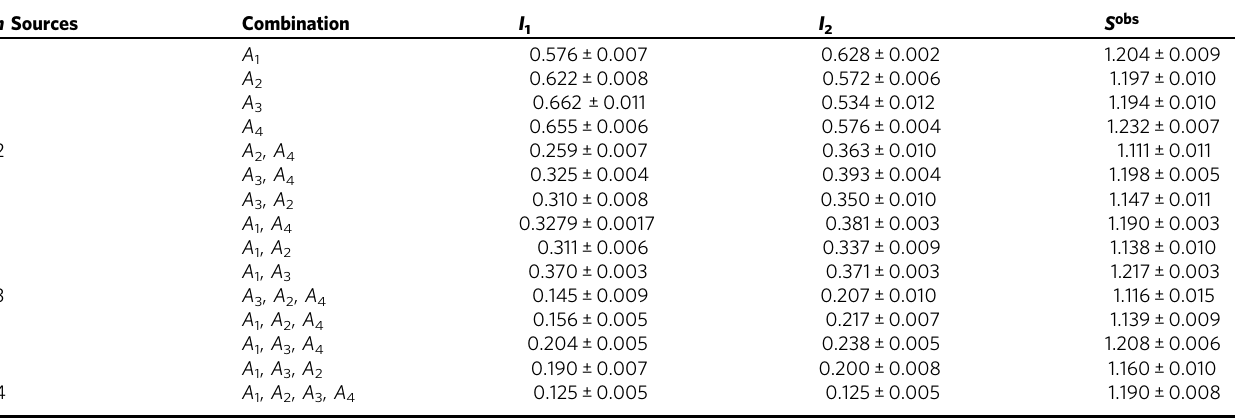
Table 1 Experimental results for different number of sources n and k = 2 measurement